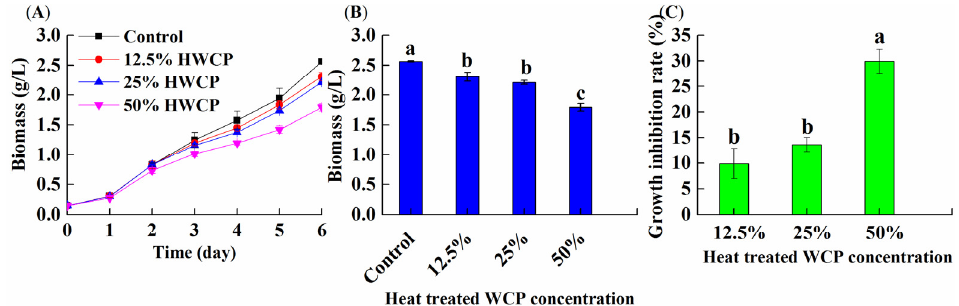
Figure 6. Effects of different concentrations of heat-treated caprolactam wastewater (HWCP) on the growth of Arthrospira platensis . ( A ) Growth curves of Arthrospira platensis , ( B ) final biomass concentration, ( C ) growth inhibition rate (%). Error bars represent the standard deviation ( n = 3). Data with different letters indicate significant differences ( p < 0.05) between the control and treatments.